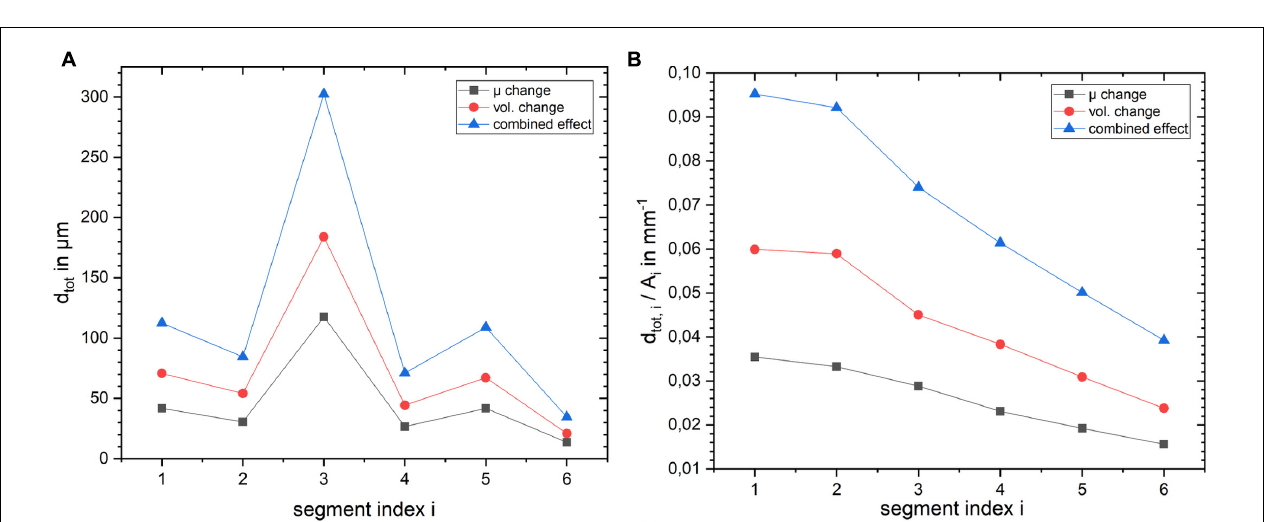
FIGURE 5 | (A) Surface plot of the total displacement for the studied region as a function of baseline stiffness and stiffness change in percent for bulk modulus κ = 5 GPa. The baseline stiffness µ = 1,400 Pa is used for all the previously discussed studies. (B) The effect of scaling the stress field on tissue displacement for the three simulation cases. The dotted line indicates the stress resulting from the flattening procedure employed in this work.